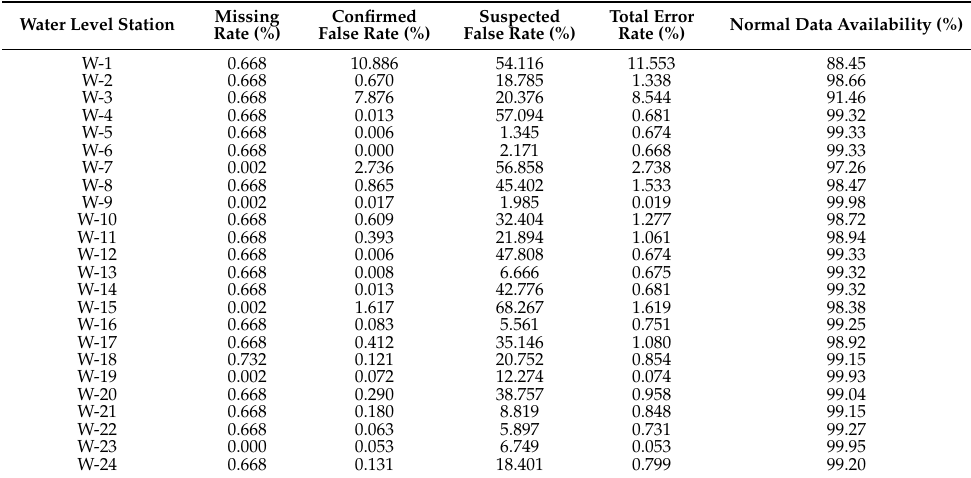
Table 7. Data availability analysis in 24 water level stations.